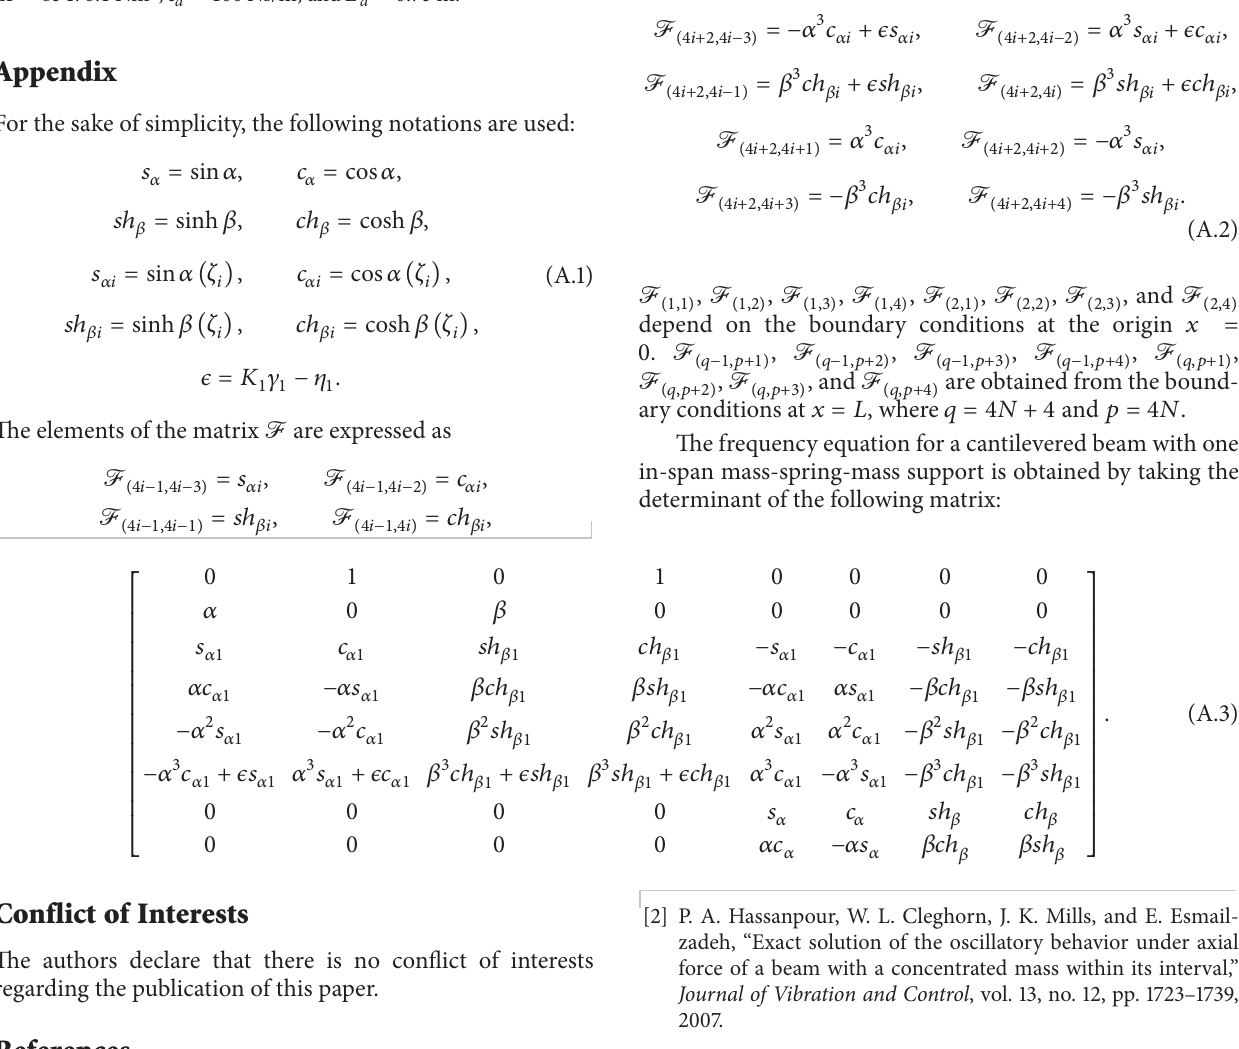
Figure 12: Frequency response amplitude error of a simply sup- ported beam carrying one in-span mass-spring-damper-mass sys- tem for 𝑘 = 190428 N/m, 𝑀 𝑑 = 3.0775 kg, 𝑀 𝑐 = 0 kg, 𝑇 = 0 N, = 100 Ns/m, and 𝐿 = 0.75 𝐸𝐼 = 63476.1 Nm 2 , 𝑐 𝑑 𝑑